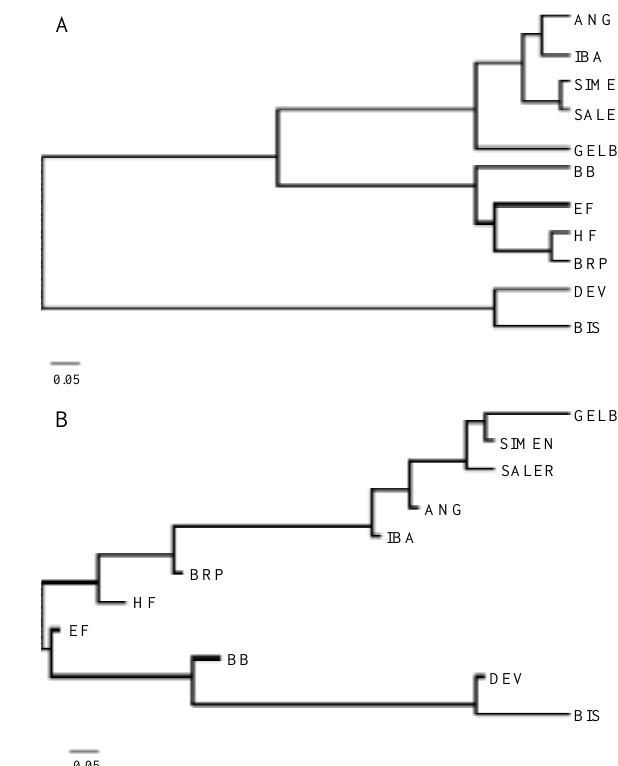
Figure 1 - UPGMA (A) and neighbor-joining (B) trees generated from D sw distance matrix. No bootstrap could be made since only TGLA122 was employed in the analysis. The trees were rooted using the midpoint method; ANG = Red Angus; IBA = Brangus Ibagé; SIMEN = Simental; SALER = Saler; GELB = Gelbvieb; BB = Belgian Blue; EF = East Flemish; HF = Holstein Friesian; BRP = Belgian Red Pied; DEV = South Devon; BIS = Bison